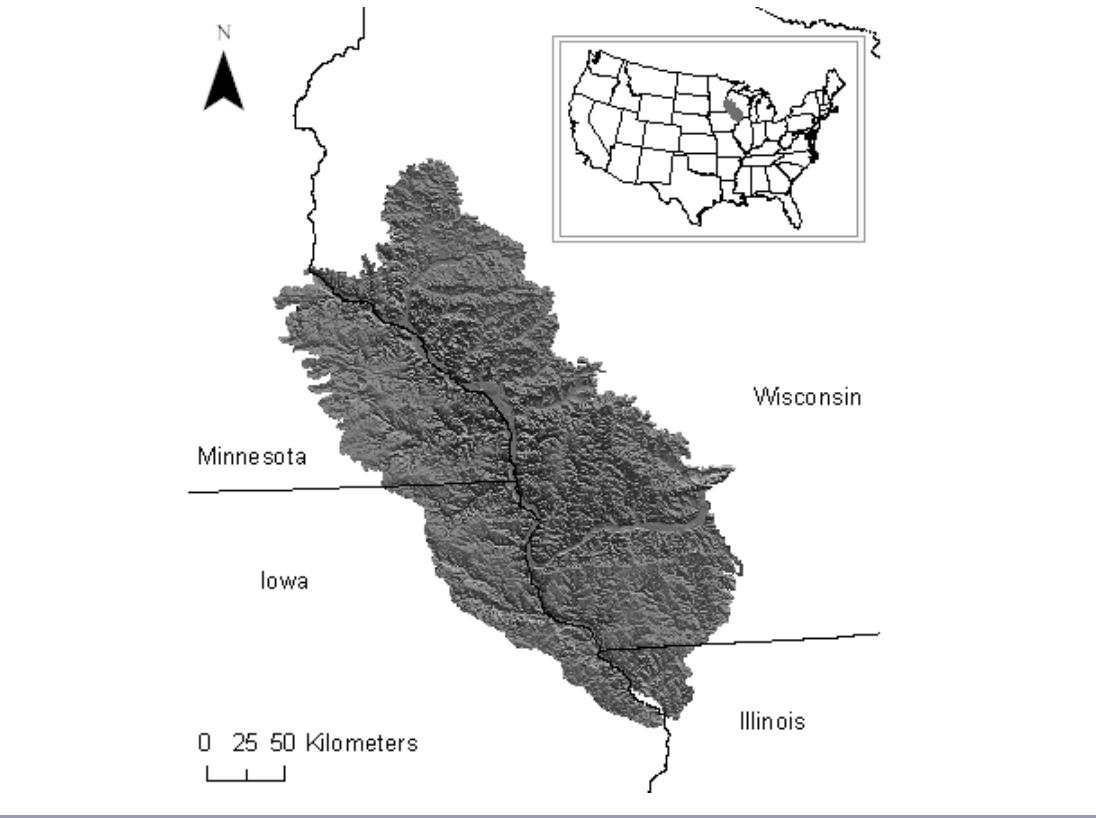
Fig. 1 . Driftless Area of the midwestern U.S., encompassing portions of four